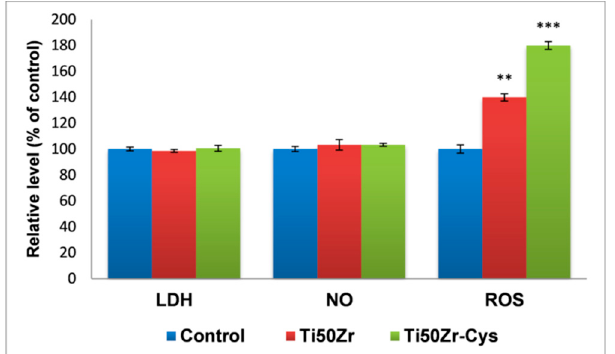
Figure 6. Cellular response revealed by LDH and NO release from gingival fibroblasts and the intracellular level of reactive oxygen species after 48 h exposure of HGF-1 gingival fibroblasts to cysteine coated Ti50Zr alloys. Data are expressed as mean ± standard deviation ( n = 3) and shown relative to control (untreated cells) (** p < 0.01 and *** p < 0.001).